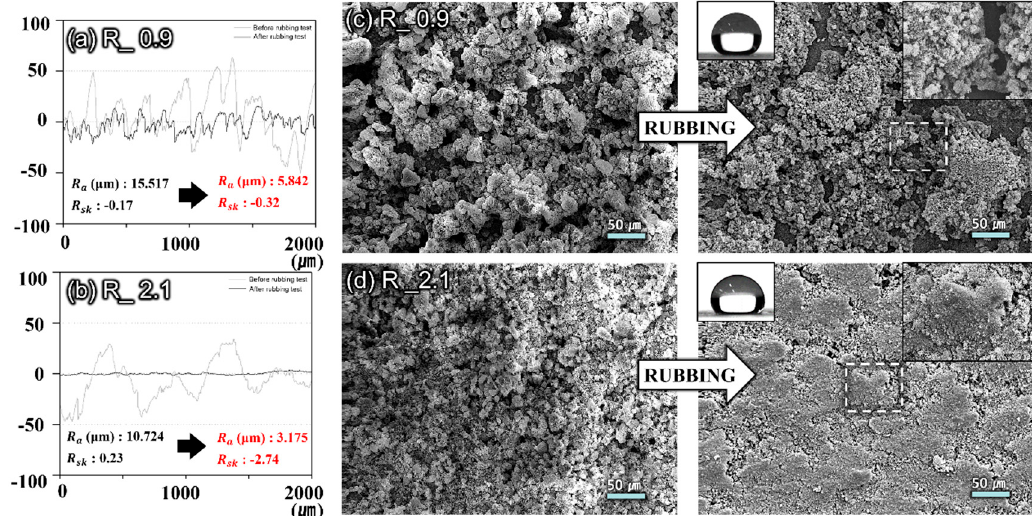
Figure 5. Roughness profiles before and after rubbing the surface with ( a ) R_0.9 ( b ) R_2.1 and SEM images before and after rubbing and contact angle images after rubbing the surface with ( c ) R_0.9 ( d ) R_2.1.